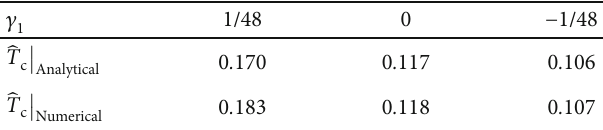
Table 2: The analytical and numerical results for the critical temperature of the holographic superconductors from the 6-derivative